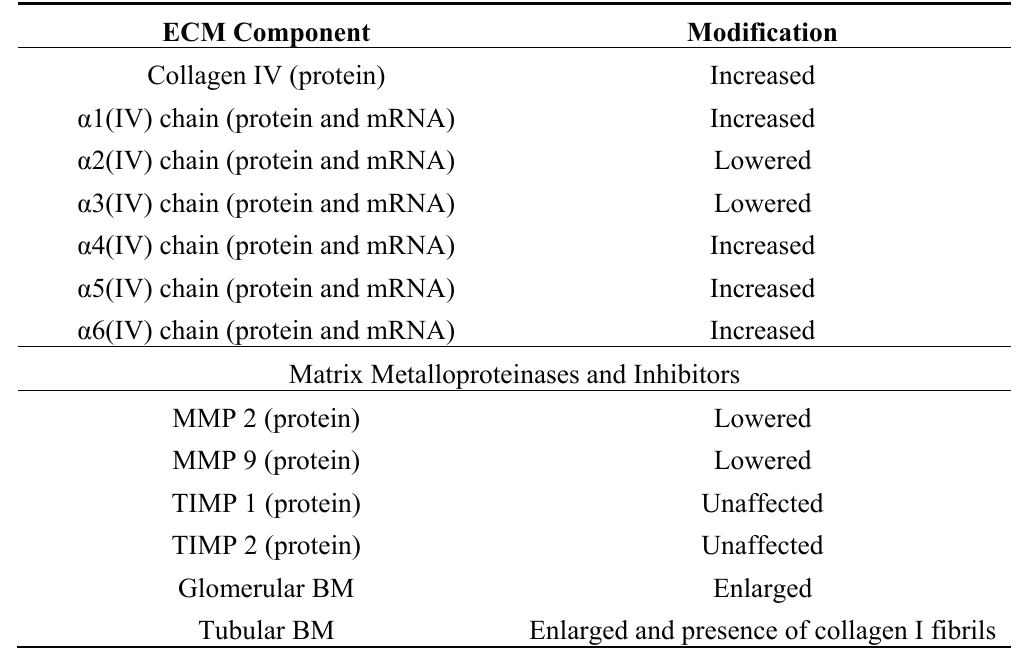
Table 1. Kidney extracellular matrix (ECM) alterations in chronic vitamin A